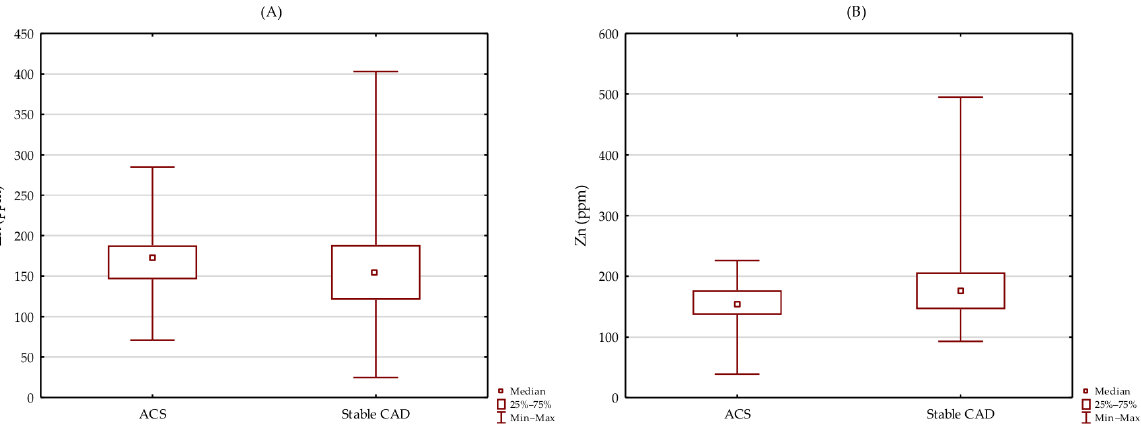
Figure 2. Differences in Zn level between patients with stable CAD and ACS in group of patients without ( A ) and with history of MI ( B ).